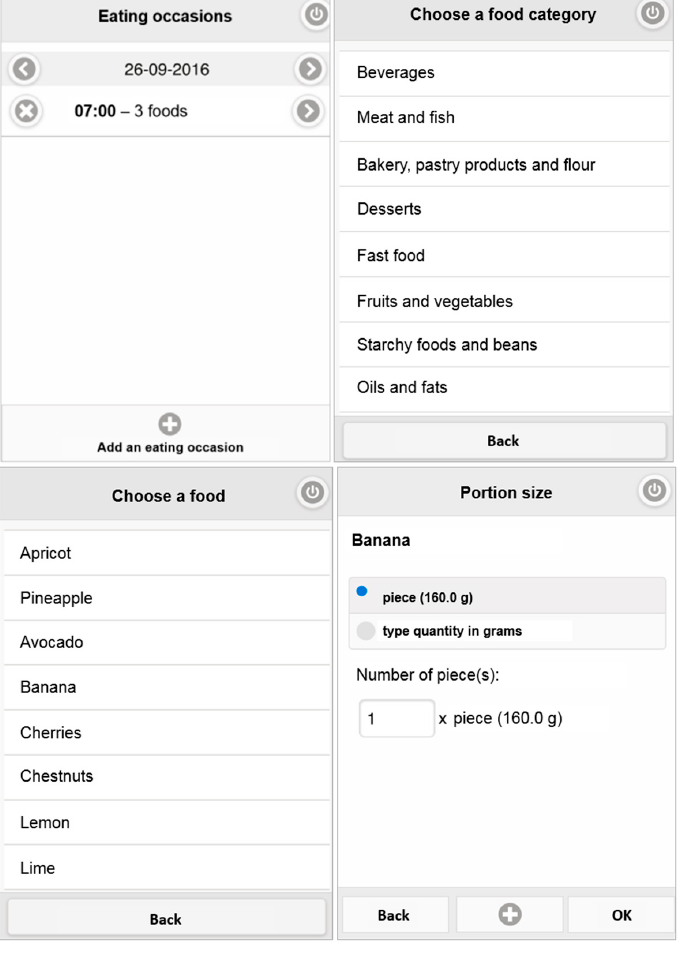
Figure 2. Screenshot illustrating the 3 steps for using e-CA: (1) creating an “eating occasion” (first picture); (2) selecting a food or drink from a category and subcategory (second and third pictures); and (3) defining the size of the portion consumed (fourth